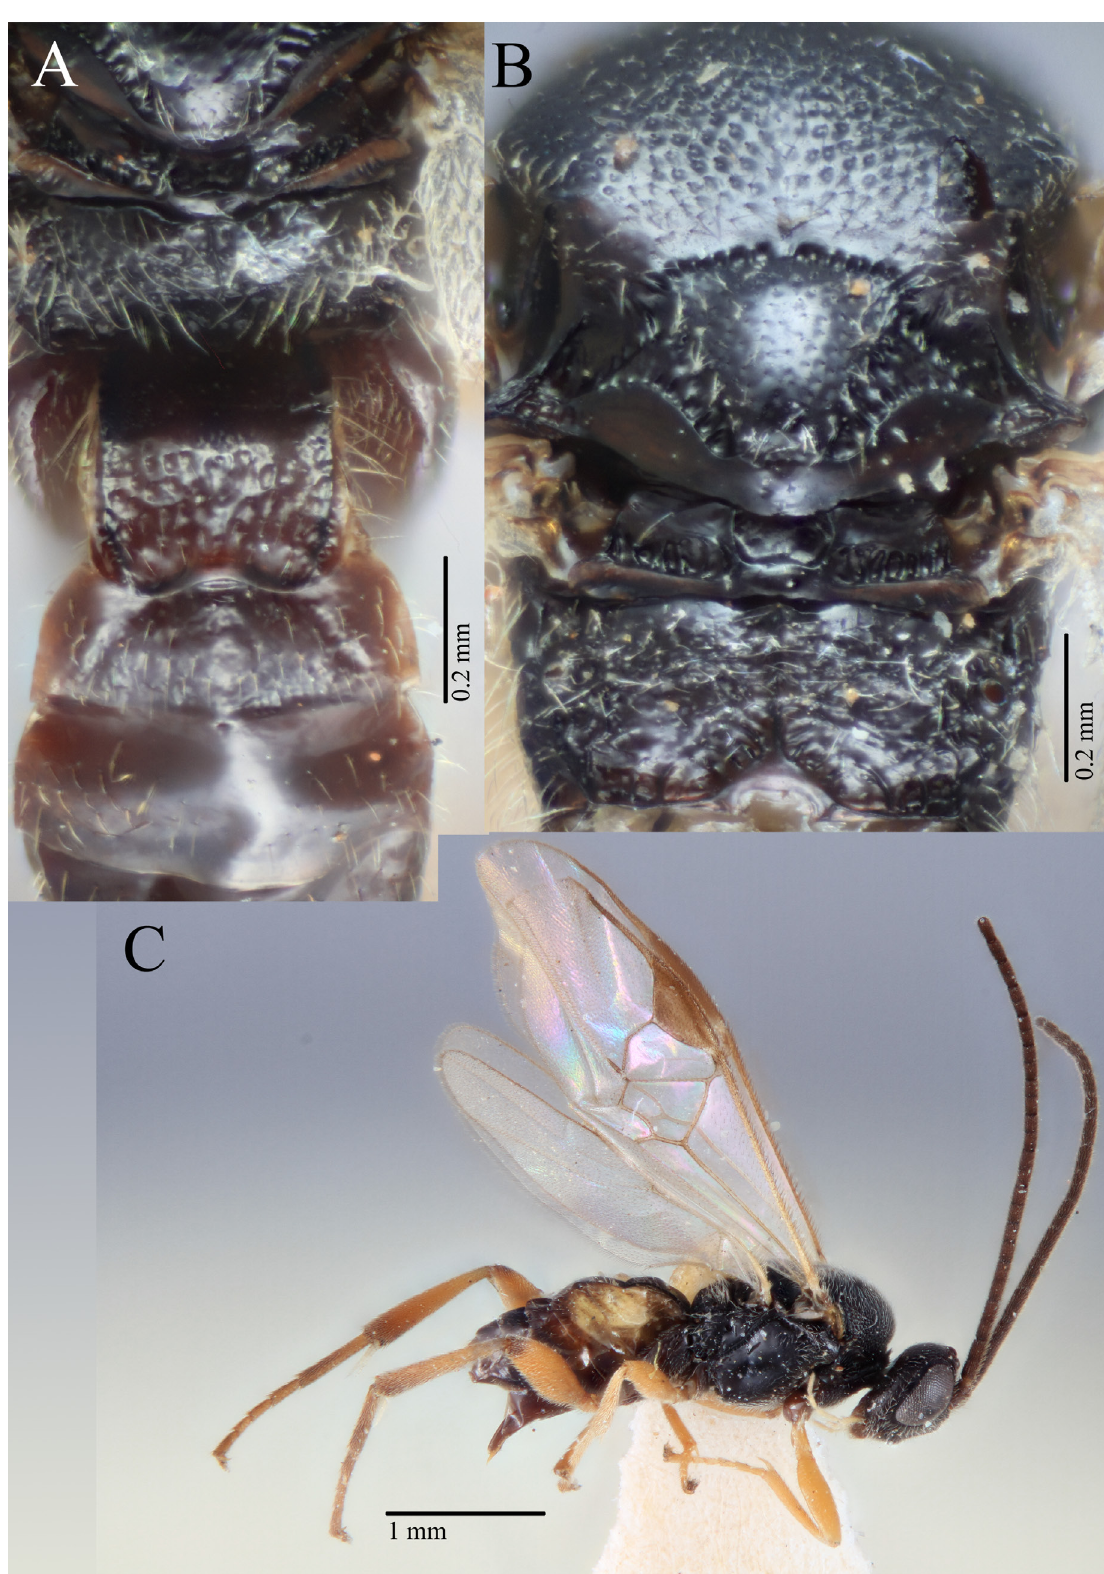
Fig. 14. Cotesia australiensis (Ashmead, 1900). A . Propodeum, T1–3 (ANIC 32 151536). B . Mesosoma (ANIC 32 151535). C . Habitus in lateral view (ANIC 32